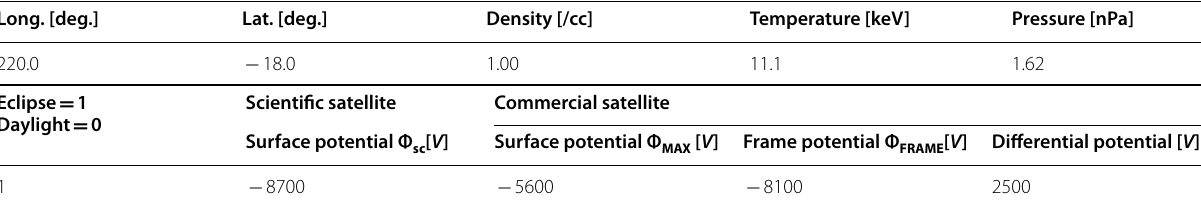
Table 1 Example of some parameters and estimated spacecraft potentials at the selected point shown as a pink cross in the right panel of Fig.